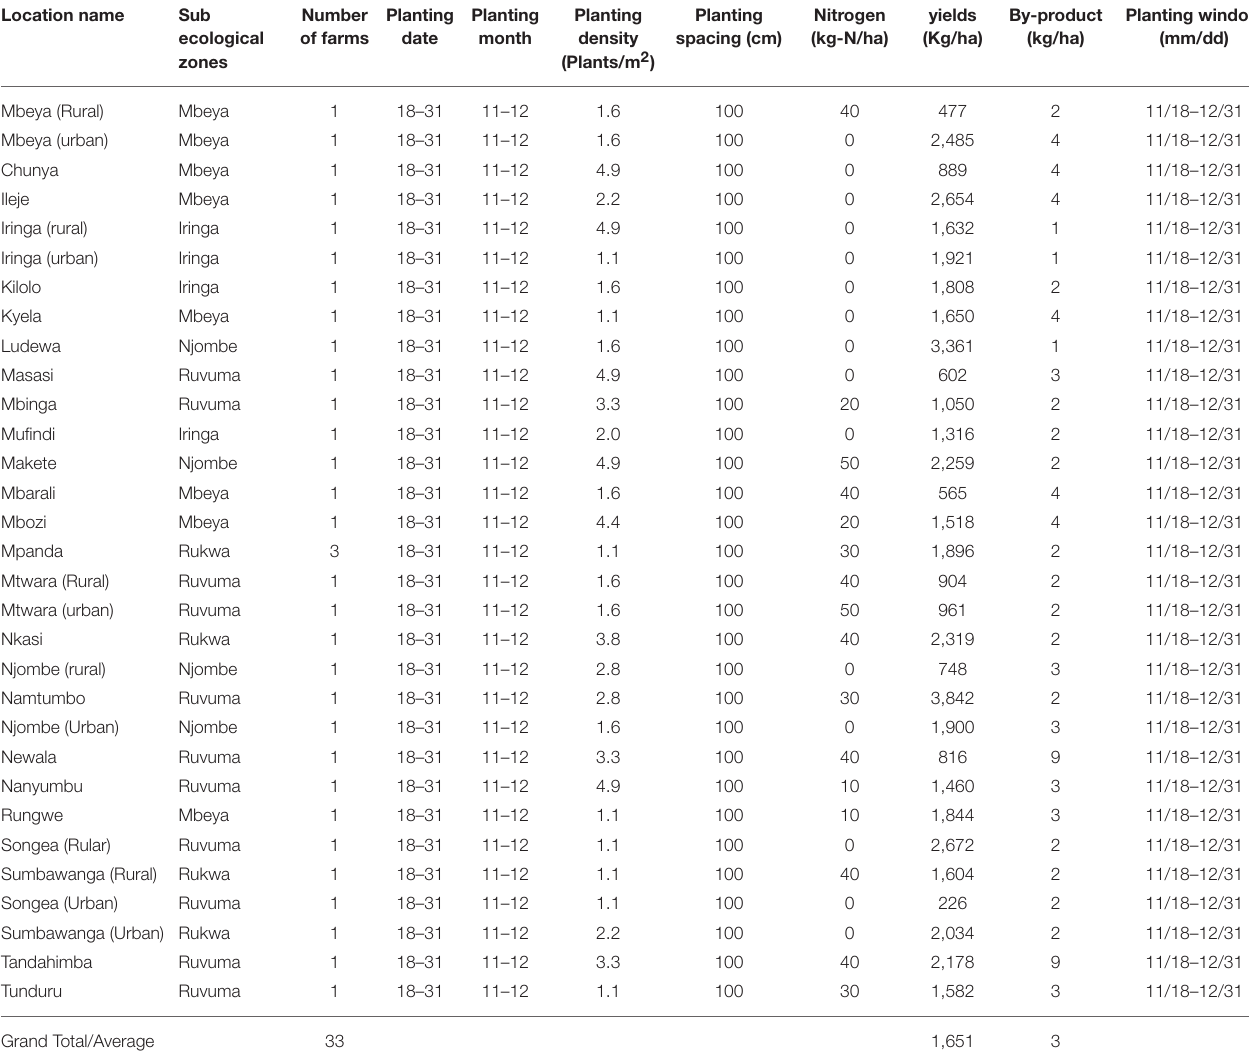
TABLE 3 | Datailed information about the farms used to create crop model data input